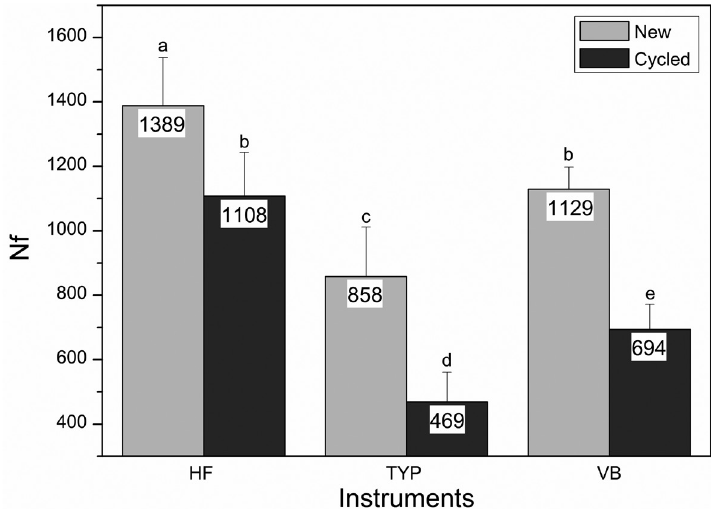
Figure 1- The mean Nf values measured in the cyclic flexural fatigue test for HF, VB and TYP instruments. New and preloaded instruments. Standard deviations (SD) are shown as error bars. Differently labeled columns represent statistically significant differences